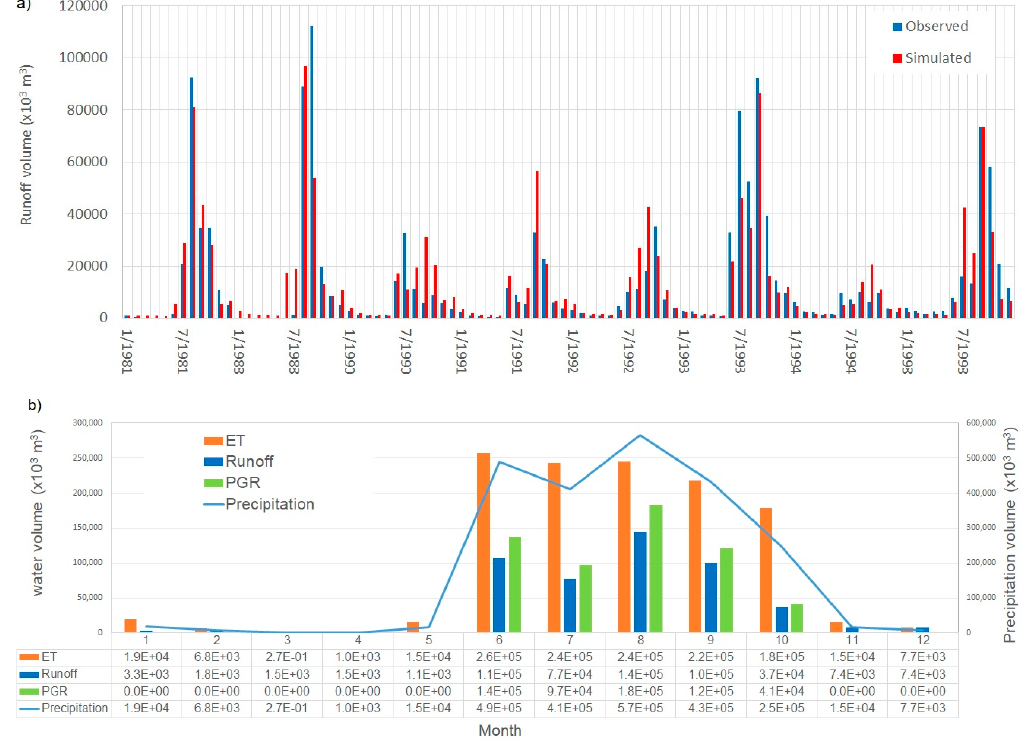
Figure 5. ( a ) Observed and simulated monthly surface runoff volume; ( b ) average monthly volume of precipitation, evapotranspiration ET, surface runoff and potential groundwater recharge PGR.